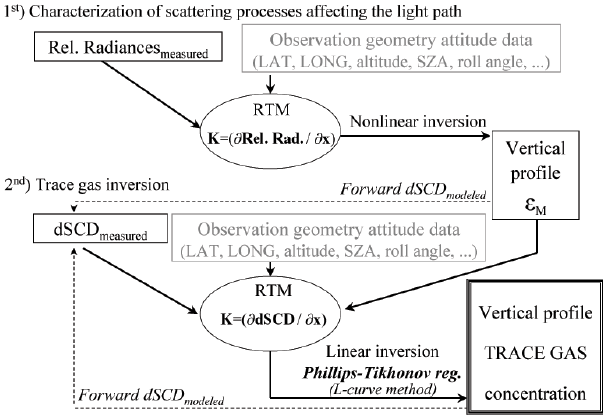
Fig. 2. Summary of the retrieval method in a two-step process: (1) inversion of the vertical distribution of the aerosols extinction coefficient affecting the RT ( E M ), and (2) inversion of the vertical profile concentration of the trace gas. Sensitivity studies of each step are performed via RT forward modeling (dashed arrows).